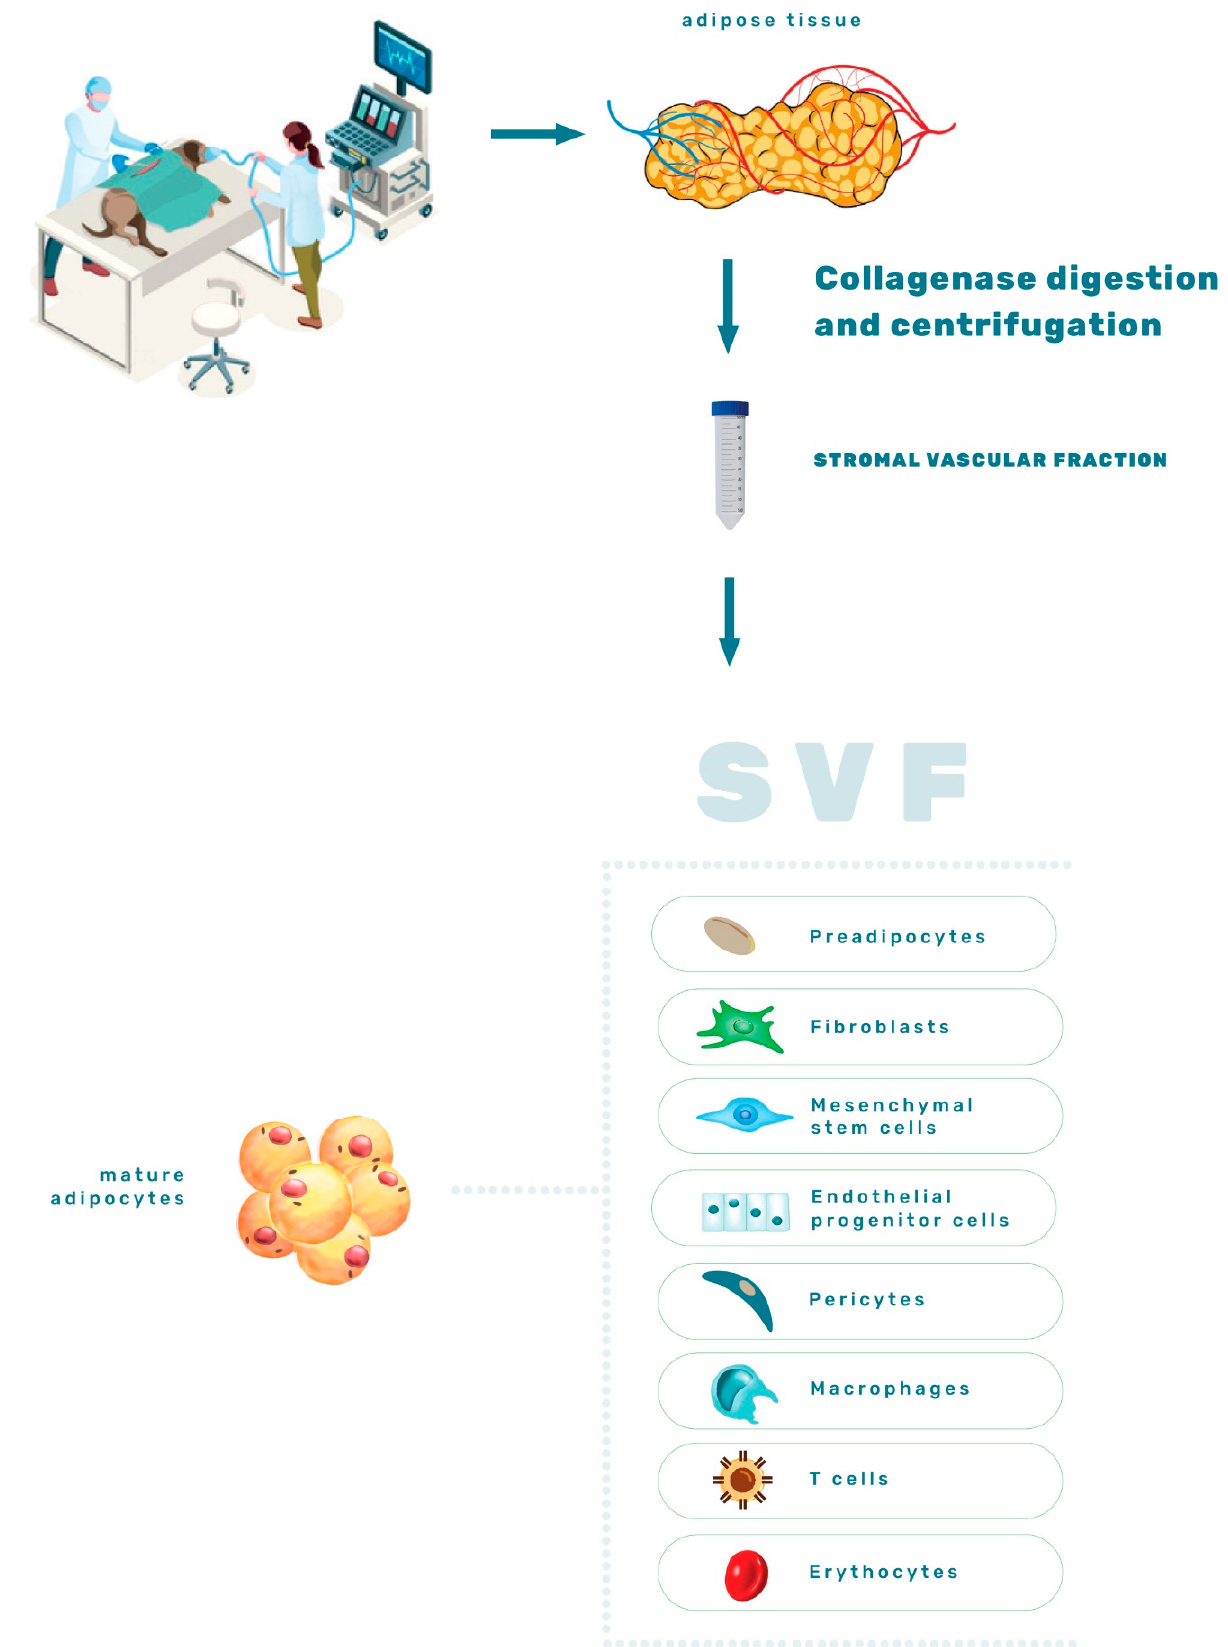
Figure 2. Graphical representation of the stromal vascular fraction components.